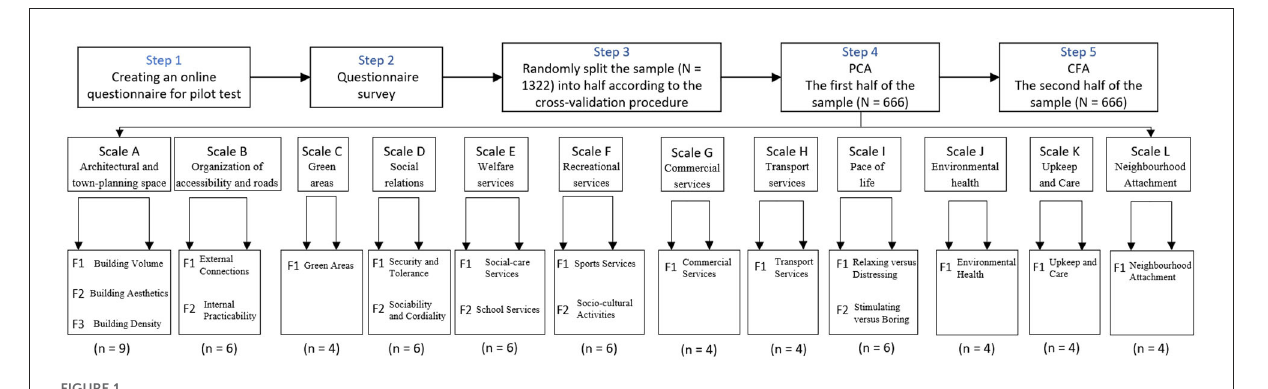
FIGURE1 Research process and the PCA results ( n is the number of items